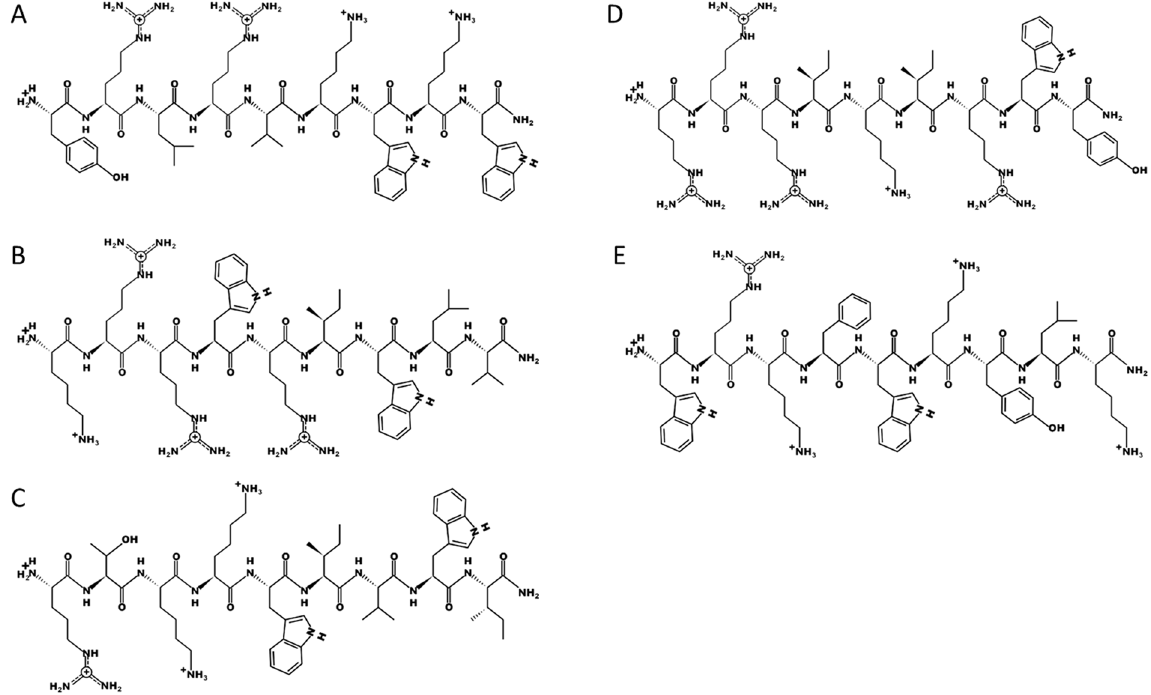
Figure 9. Two dimensional drawing of the five selected peptides using the PepDraw online software. ( A ) AMP1, ( B ) AMP2, ( C ) AMP3, ( D ) AMP4 and ( E )